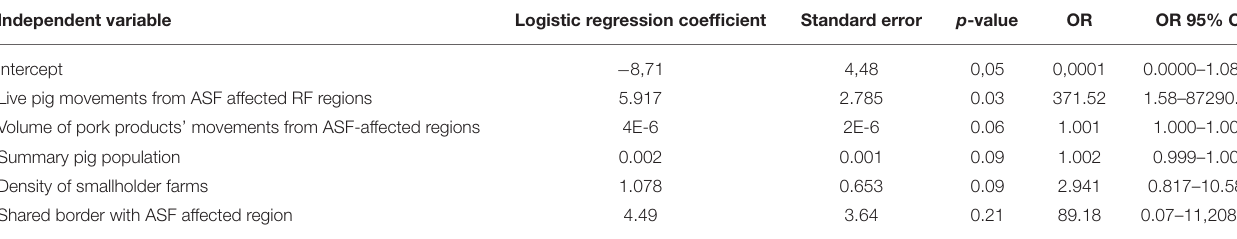
TABLE 3 | Logistic regression metrics. Independent variable Logistic regression